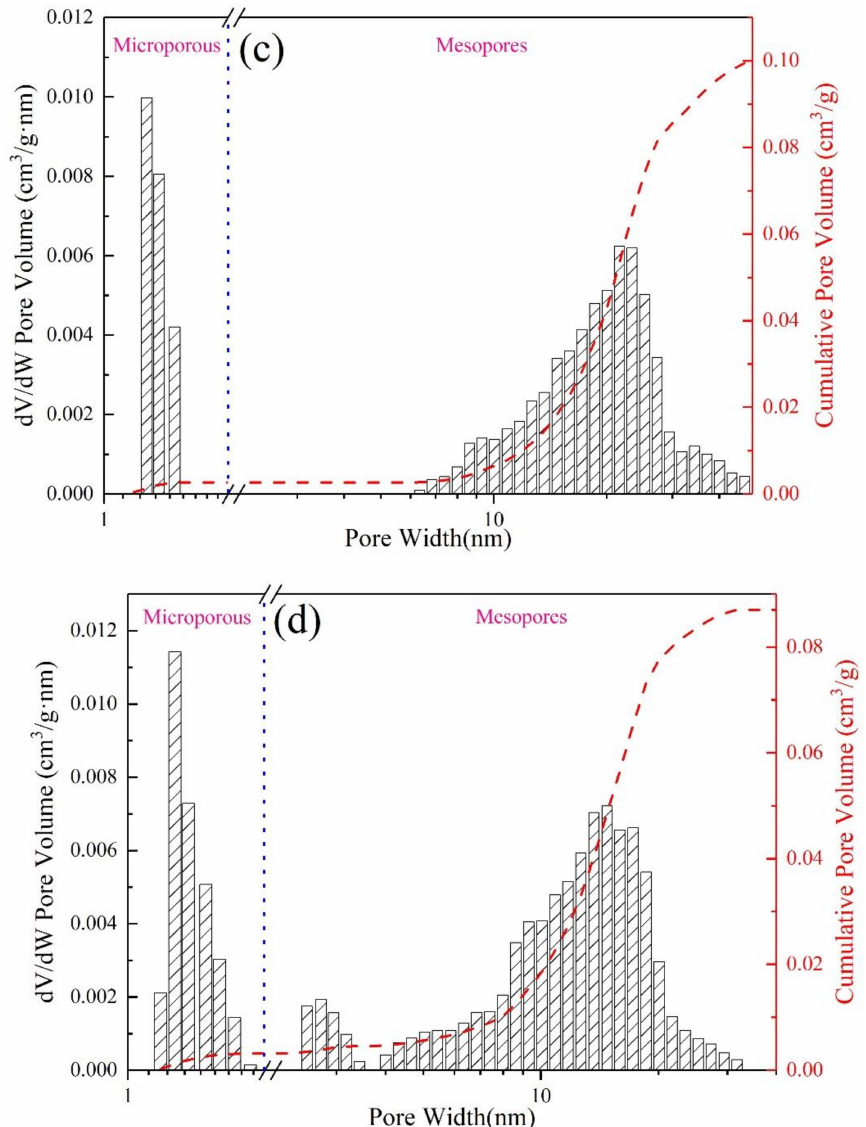
Figure 8. DFT pore size distribution characterization for ( a ) FAA1.0, ( b ) AF0.5-2, ( c ) AF1-1, and ( d )